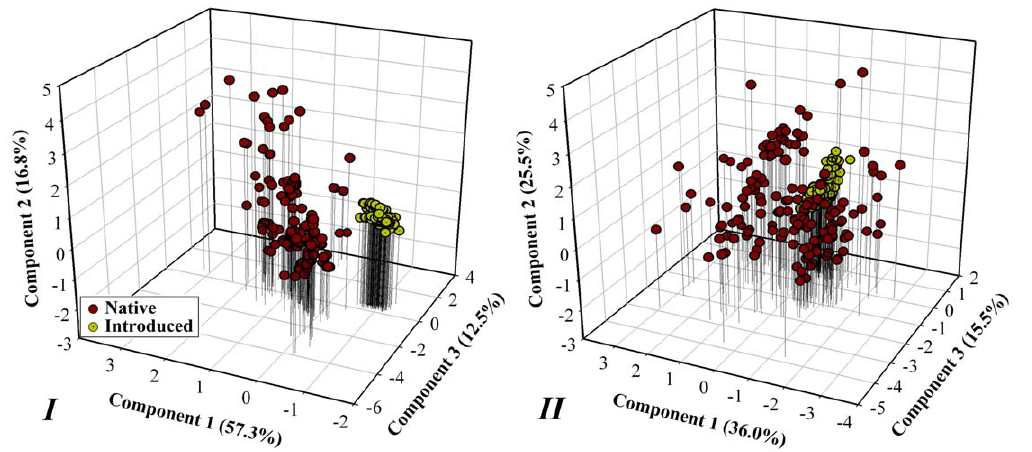
Figure 2. Principal component analysis of Dataset I (left) and II (right) associated with occurrences of Bean plataspid. Symbols represent Bean plataspid occurrences in native and introduced areas.